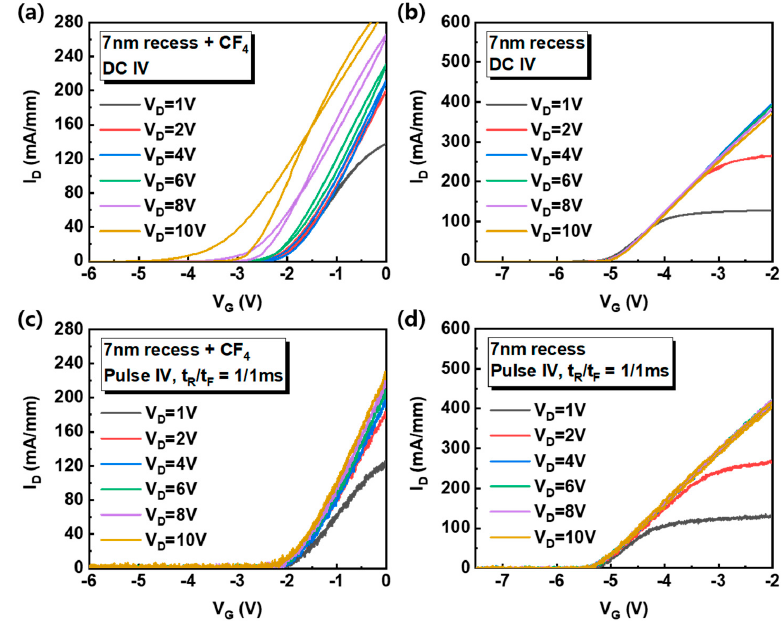
Figure 5. ( a , b ) The dual swept DC I-V transfer curve of 7-nm recess + CF 4 and 7-nm recess devices measured at various V D . ( c , d ) Pulsed I-V curve of 7-nm recess + CF 4 and 7-nm recess devices measured for various V D . The rising and falling time of 1 ms was used for pulse measurement.